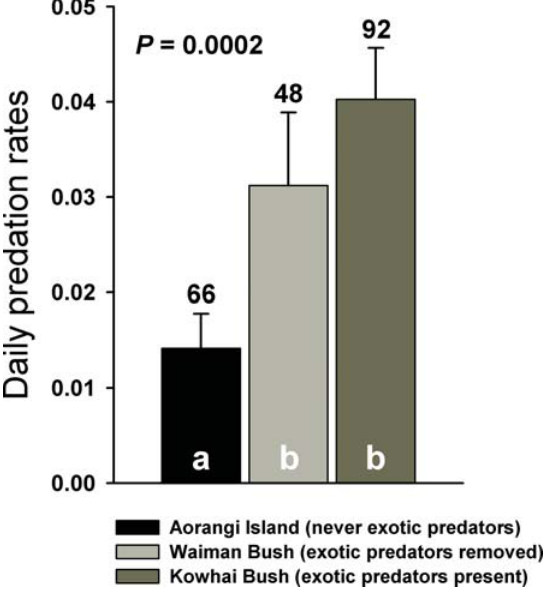
Figure 1. Daily nest predation rates for bellbirds on Aorangi Island, where exotic predators were never introduced, in Waiman Bush, where exotic predators were removed, and in Kowhai Bush, where all exotic predators are present. Shared letters within bars denote non-significant (i.e., p . 0.05) statistical differences using the CONTRAST programme [41]. Figures above bars are the number of nests in each study site.